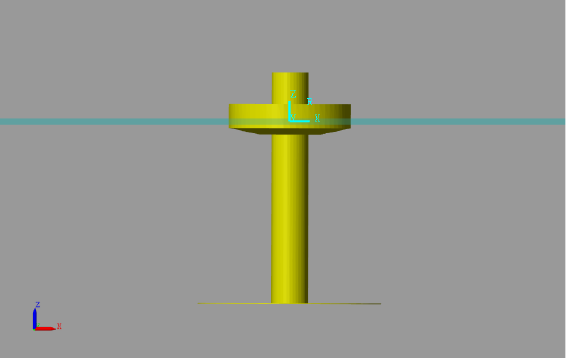
Fig. 8. The RM3 point absorber with still water level and coordinate